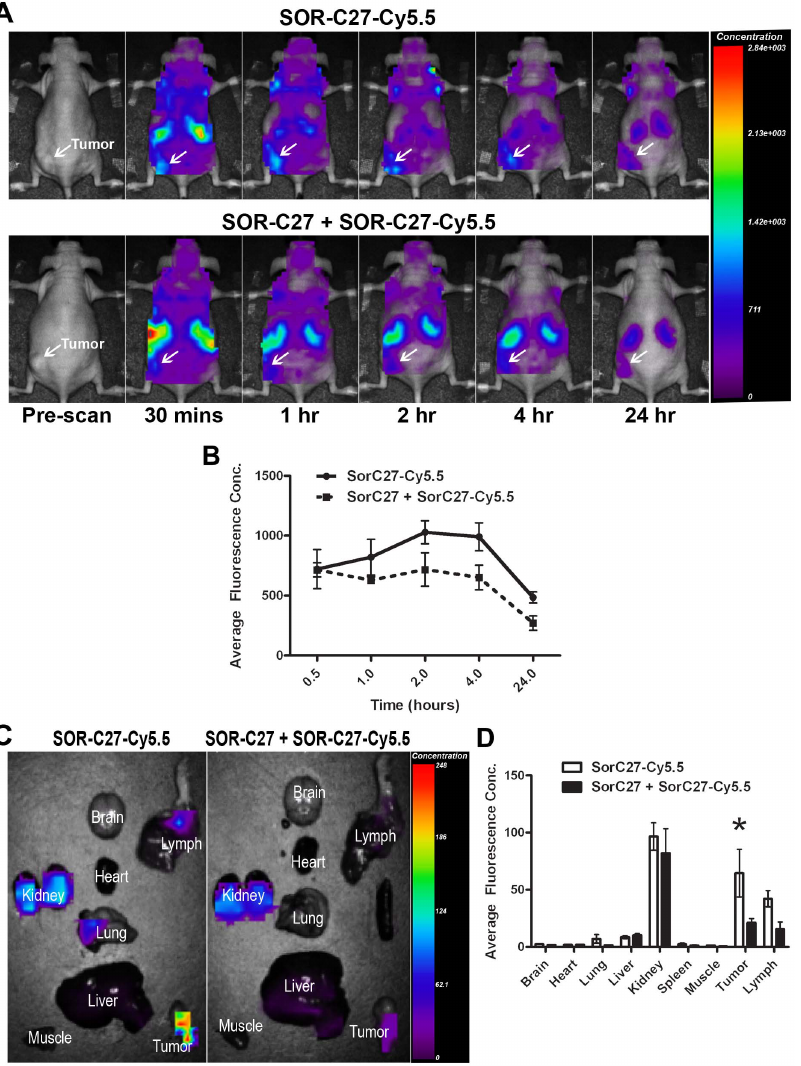
Figure 4. Invivo optical imaging of mice bearing SKOV-3 xenograft tumors after i.p. administration of 100 m g of SOR-C27 tagged with Cy5.5. Dorsal whole-body images at indicated time points after injection of either SOR-C27-Cy5.5 (upper panels of A ) or SOR-C27-Cy5.5 competitively blocked by 100 fold excess of SOR-C27 (lower panels of A ). Arrows indicate the location of the solid subcutaneous tumor in the flank of the animal. Graph illustrating the changes in average fluorescence concentration in the tumor at indicated times after injection of SOR-C27-Cy5.5 or SOR-C27-Cy5.5 competitively blocked by SOR-C27 ( B ). Ex vivo optical images of mouse organs 24 hours post-injection of SOR-C27-Cy5.5 alone (left panel of C ) or SOR-C27-Cy5.5 competitively blocked by SOR-C27 (right panel of C ). Graph illustrating the average fluorescence concentration imaged ex vivo in various tissues 24 hours post-injection of SOR-C27-Cy5.5 or SOR-C27-Cy5.5 competitively blocked by SOR-C27 ( D ). *Indicates significant difference between SOR-C27-Cy5.5 and SOR-C27-Cy5.5 competitively blocked SOR-C27-Cy5.5 ( p , 0.05). In B and D , data are expressed as mean 6 SEM for n =3 animals.